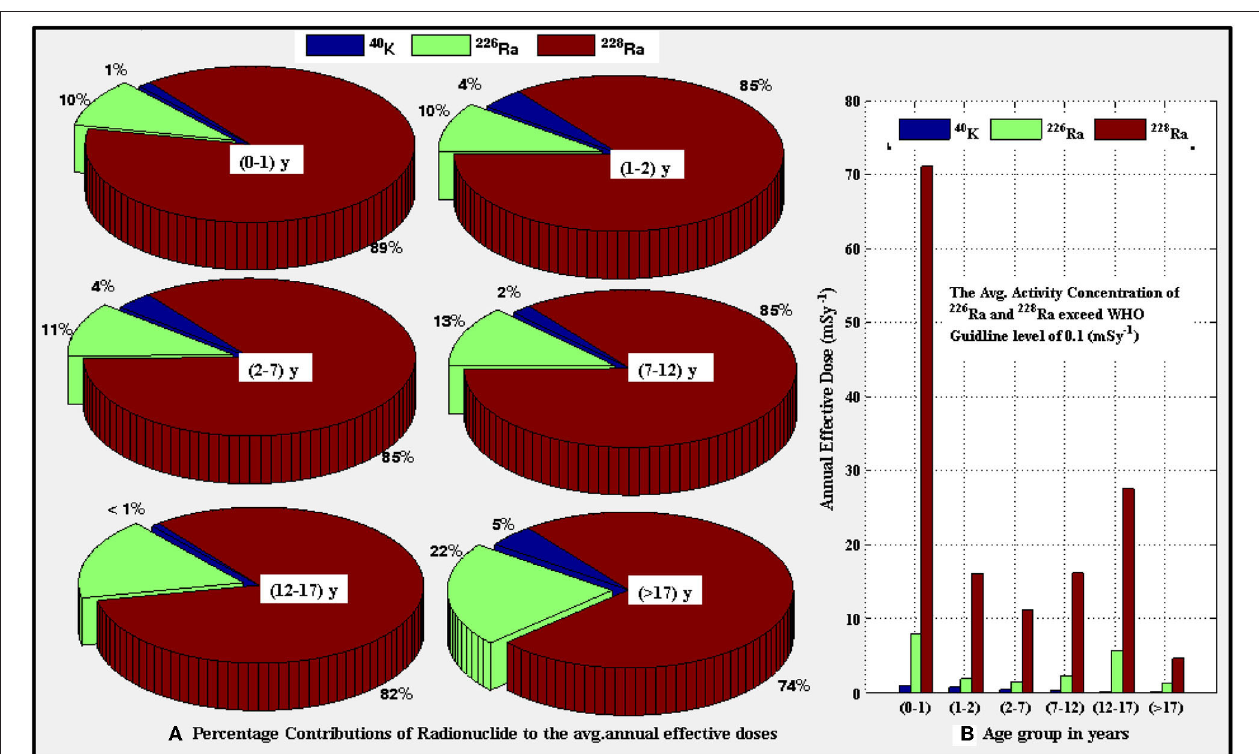
FIGURE 2 | (A) Percentage contributions of the radionuclides to the annual effective dose for different age range (B) Distribution of the mean annual effective dose due to the presence of 40 K, 226 Ra, and 228 Ra for various age